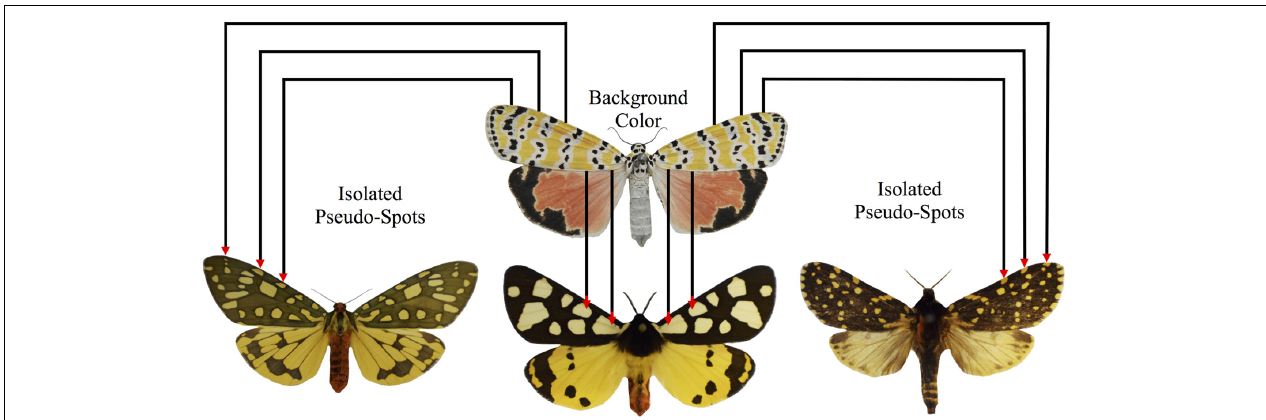
FIGURE 9 | “Pesudospots” are islands of background coloration formed through the incomplete fusion of primary pattern elements. In some species of tiger moths, it is possible to identify apparent spotted elements that are not depicted on the arctiitype. We predict that these are not true developmentally individuated characters, but instead, are byproducts that arise accidentally through the incomplete fusion of the primary pattern elements. A sample specimen of U. ornatrix displaying broad patches of orange background coloration that separate the various primary pattern elements is shown at the top of the figure. In the bottom row (left: Aglaomorpha plagiata ; middle: Arctia villica .; right: Phaegoptera aurogutta ), the corresponding patches of background coloration have been transformed into pseudospots due to increases in the size of the primary pattern elements, the inclusion of venous stripe details, and changes in overall wing geometry.